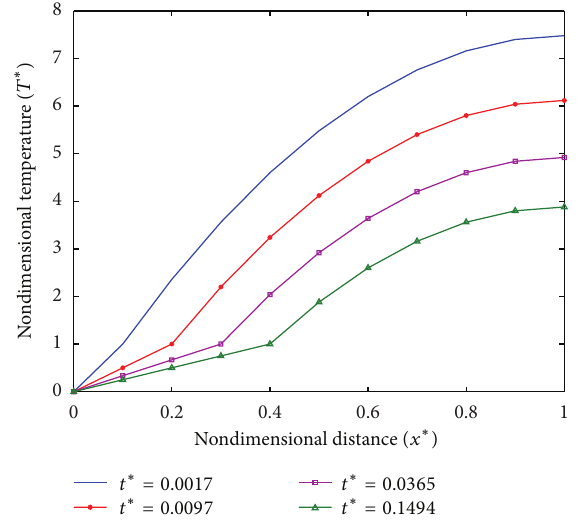
Figure 4: Temperature distribution at 𝑞 ∗ 𝑚 = 16 .